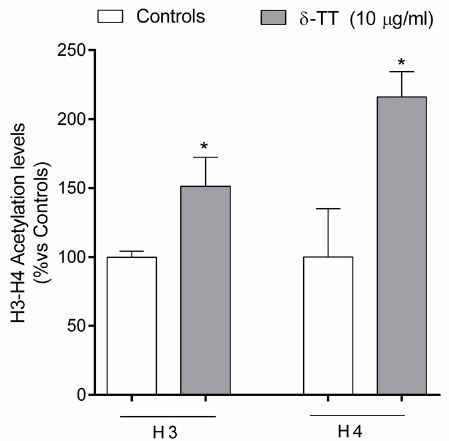
Figure 10. δ -TT increases global H3 and H4 acetylation levels in MC3T3-E1 cells. Cells were treated with δ -TT (10 µ g / mL) for 24 h and the histones were collected. The acetylation of H3 and H4 was measured by a colorimetric assay. Absorbance was read at 450 nm. The data are presented as the mean ± SEM of three independent experiments. * p < 0.05 vs. controls.